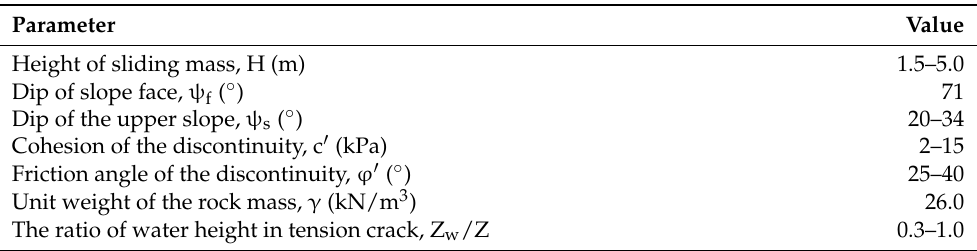
Table 1. Range of values of the parameters to be determined by limit equilibrium back-analyses for planar failures.